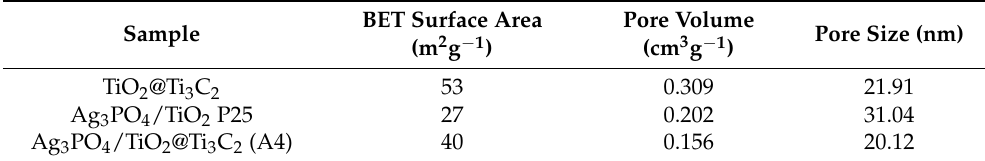
Table 1. Specific surface area, pore volume, and pore size distribution of TiO 2 @Ti 3 C 2 , Ag 3 PO 4 /TiO 2